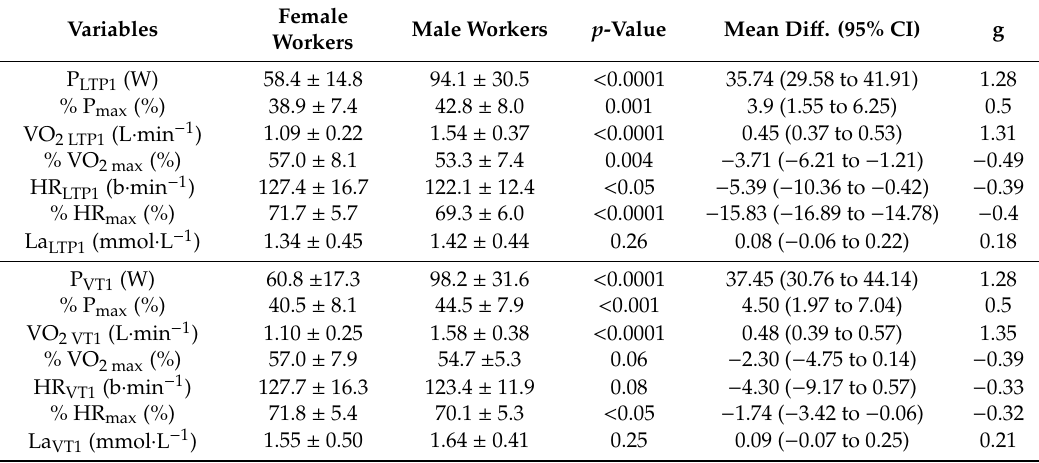
Table 3. Power output (P), oxygen uptake (VO 2 ), heart rate (HR) and blood lactate concentration (La) at the first lactate (LTP 1 ) and ventilatory threshold (VT 1 ) with corresponding percentages to the maximal